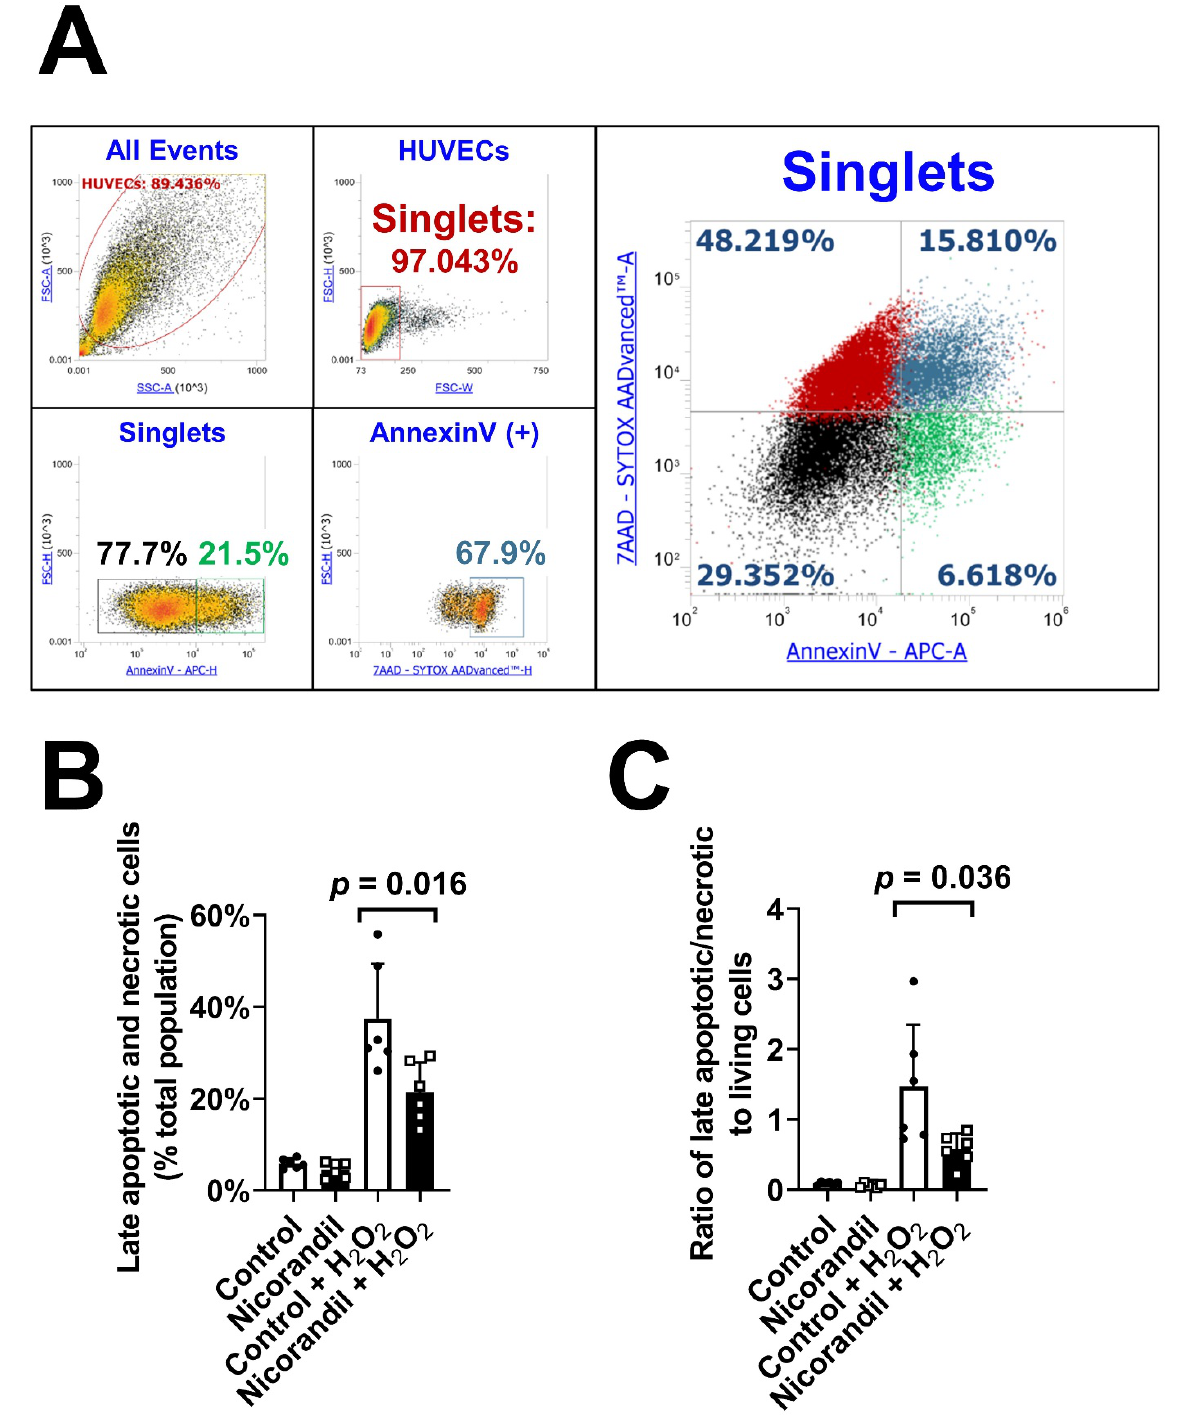
Figure 4. Effect of nicorandil treatment on apoptosis in endothelial cells. ( A ) Gating strategy; cell debris was excluded from analysis using forward/sideward scatter plot. Subsequently, singlets were gated using FSC width vs. FSC height and split into AnnexinV +/- and 7-AAD +/- cells. Backgating into the singlet population revealed double-positive (late apoptotic/necrotic) and double-negative cells (intact, living cells). A total of 25 µ M H 2 O 2 was added to pretreated endothelial cells (500 µ M nicorandil) for a duration of 4 h. Pretreatment with nicorandil significantly reduced the percentage of late apoptotic/necrotic cells ( B ) and decreased the ratio of late apoptotic/necrotic to living cells ( C ). All values given represent means ± standard deviations; the statistical significance of p ≤ 0.05 was considered significant.